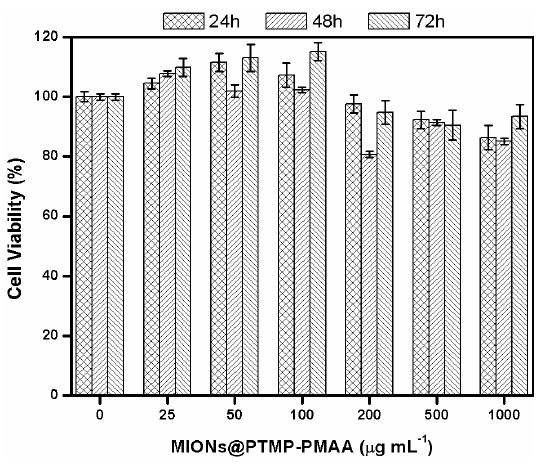
Figure 10. Cell viability of HepG2 determined by MTT-assay after 24, 48 and 72 h of incubation with various concentrations of MIONs@PTMP-PMAA.